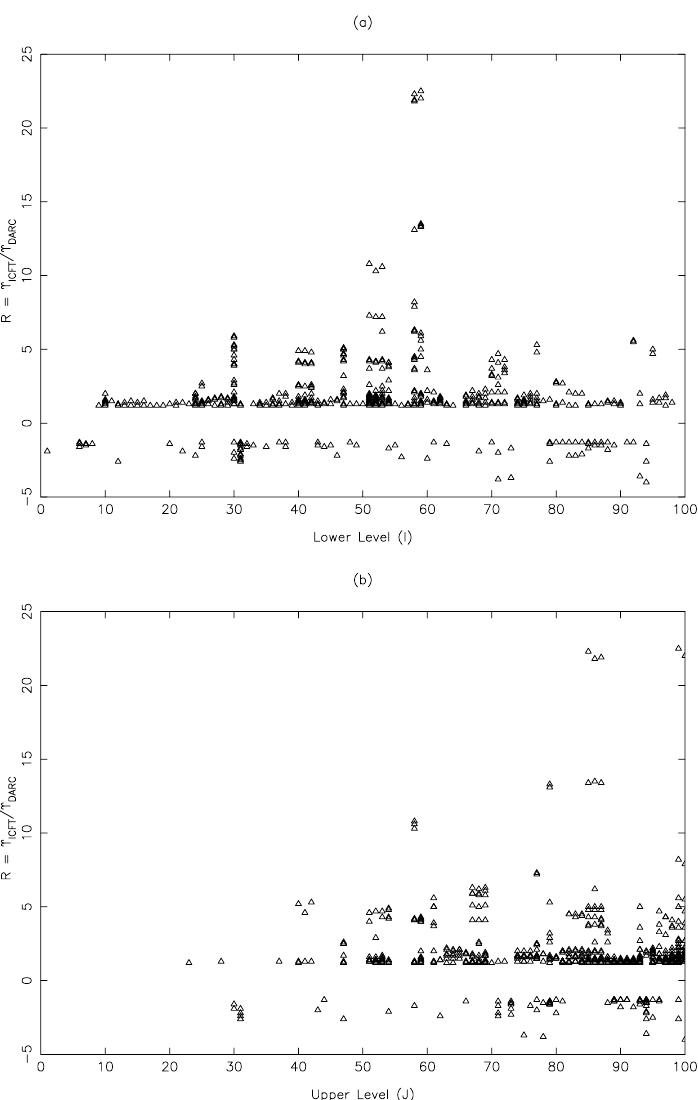
Figure 3. Comparison of DARC [33] and ICFT [26] values of Υ for transitions of N IV at T e = 1.6 × 10 5 K. Negative R values plot Υ DARC / Υ ICFT and indicate that Υ DARC > Υ ICFT . Only those transitions are shown that differ by over 20%. ( a ) Transitions from lower and ( b ) to upper